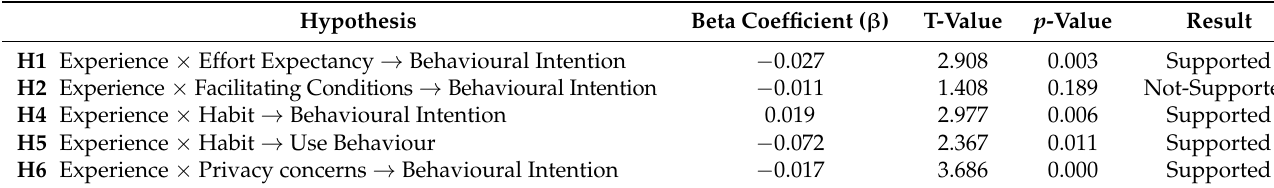
Table 5. Moderating effect of